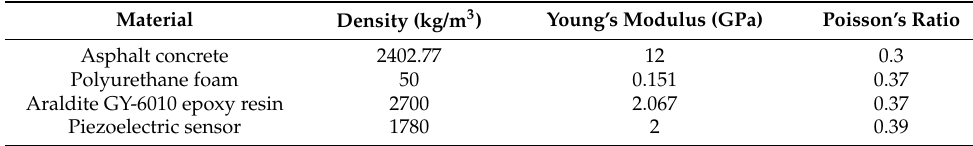
Table 1. Key material properties used in FEM.